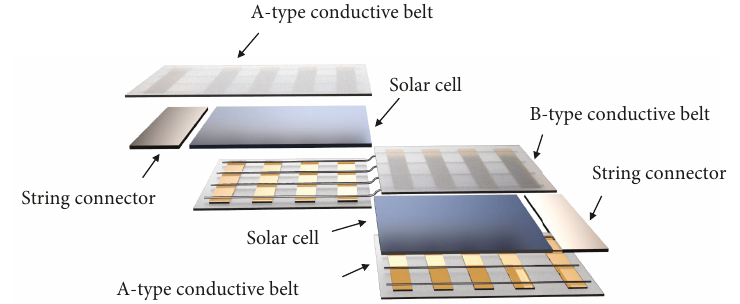
Figure 1: The structure and the connect mode of the conductive